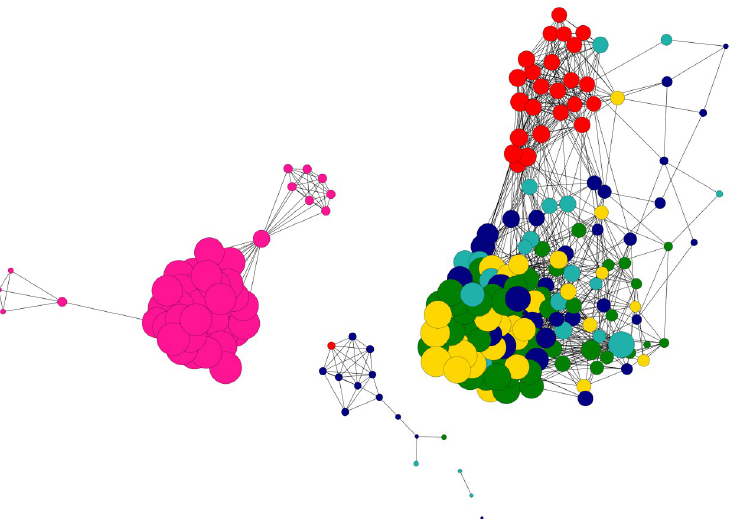
Fig 2. High resolution population network of Fijian Holothuria scabra generated using Netview R [45]. The network has been visualised at a maximum number of nearest neighbour (k-NN) threshold of 30, using 6,896 SNPs and 211 individuals. Each dot represents a single individual, and population colours correspond with Fig 1. Node sizes have been mapped to the relatedness (neighbourhood connectivity based on IBS distances) of individual animals, and the network constructed using the organic topology framework option in Cytoscape